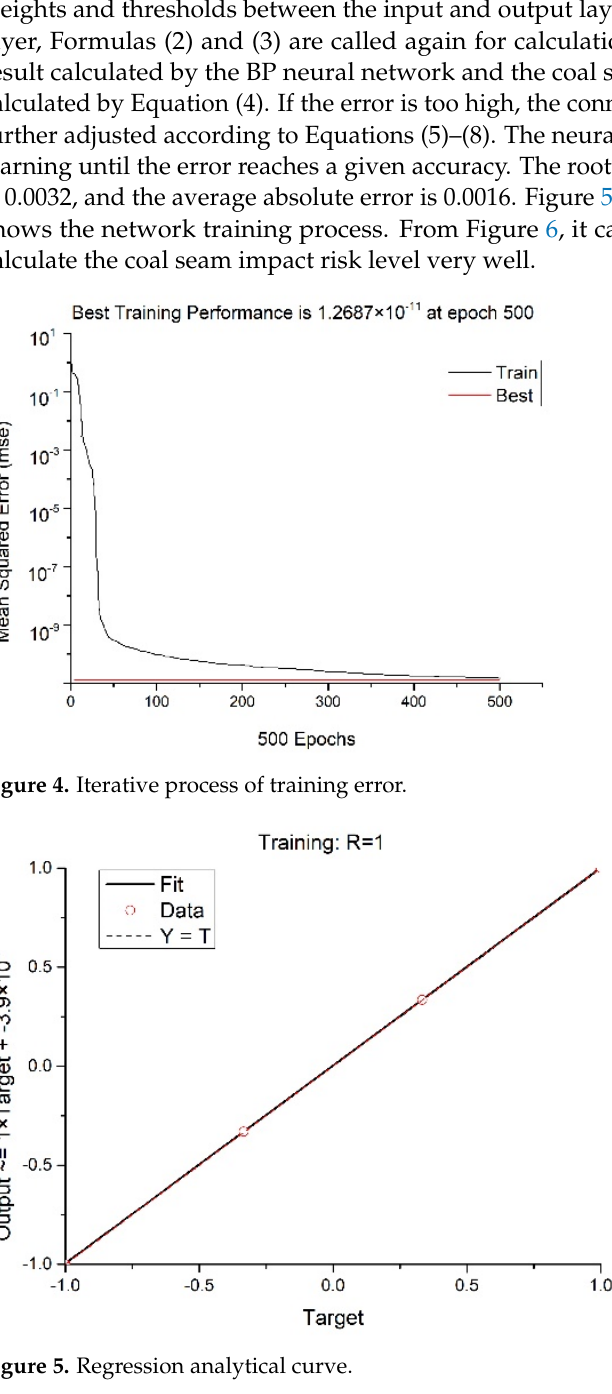
Figure 6. Network training performance analysis chart. 5. Project Example Application Taking a mine in Inner Mongolia as an example, the coal seam impact risk of the 2-1 coal seam is evaluated to verify whether the constructed model can be used for mine coal seam impact risk assessment. It is known that the mining depth of the coal seam is 626.17 m~647.91 m, the average mining depth is 637 m, the average dynamic failure time is 45.6 ms, the average elastic energy index is 20.76, the average impact energy index is 10.03, and the average uniaxial compressive strength is 28.52 Mpa. The bending energy indices of the rock formation and the floor are 43.37 kJ and 69.51 kJ, respectively. The overall structural form of the minefield where the coal seam is located is a monoclinic structure